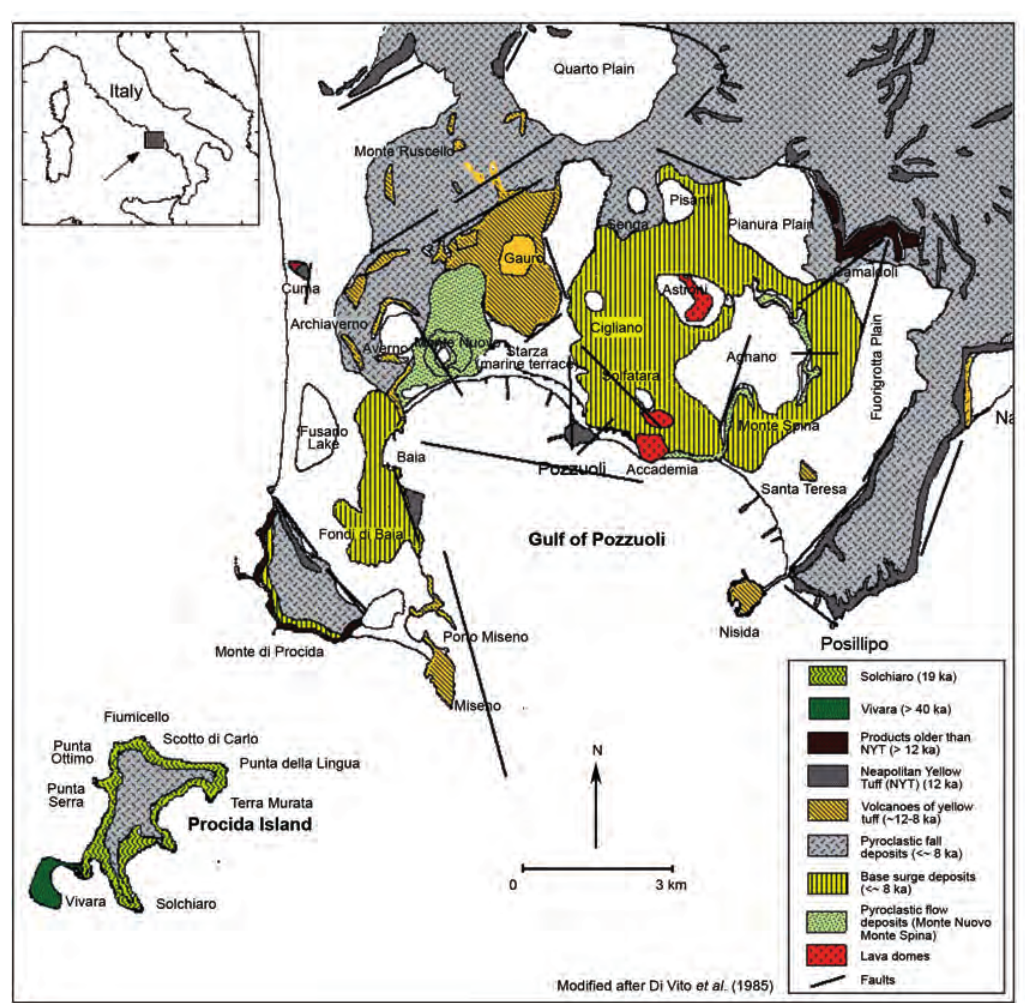
Fig. 2. Schematic geological map of the Phlegraean Fields (Scandone,